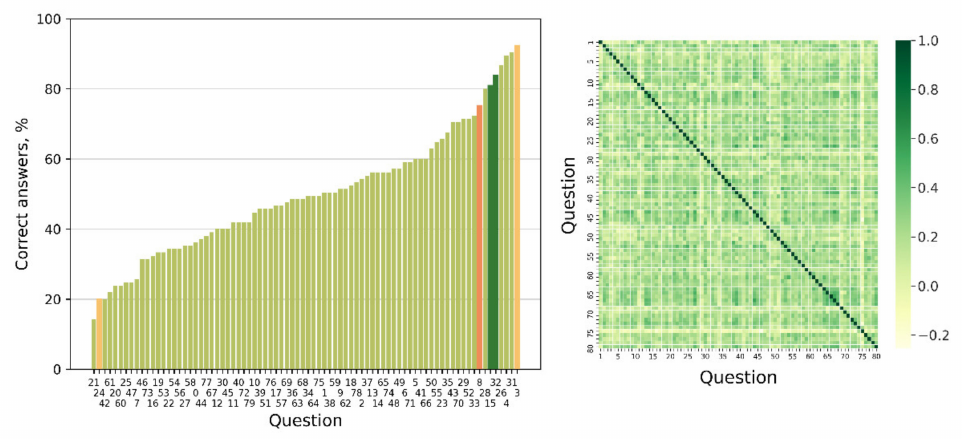
Figure 8. Question difficulties in 2021 dataset on the left and item correlation matrix on the